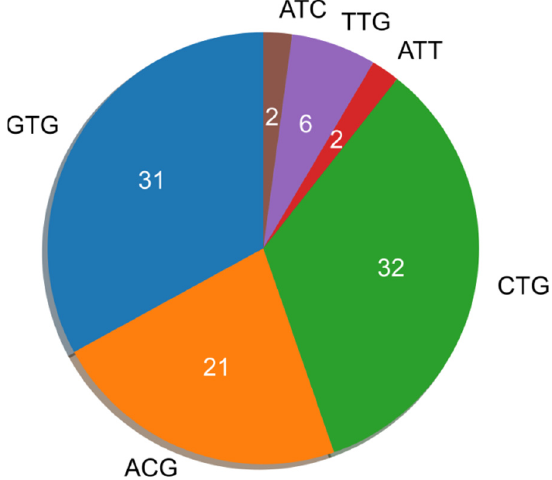
Figure 1. Noncanonical TICs from selected cancer genes.